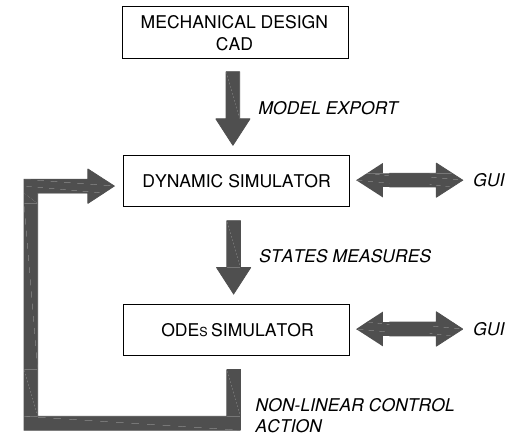
Figure 4 CAE simulator flow chart.